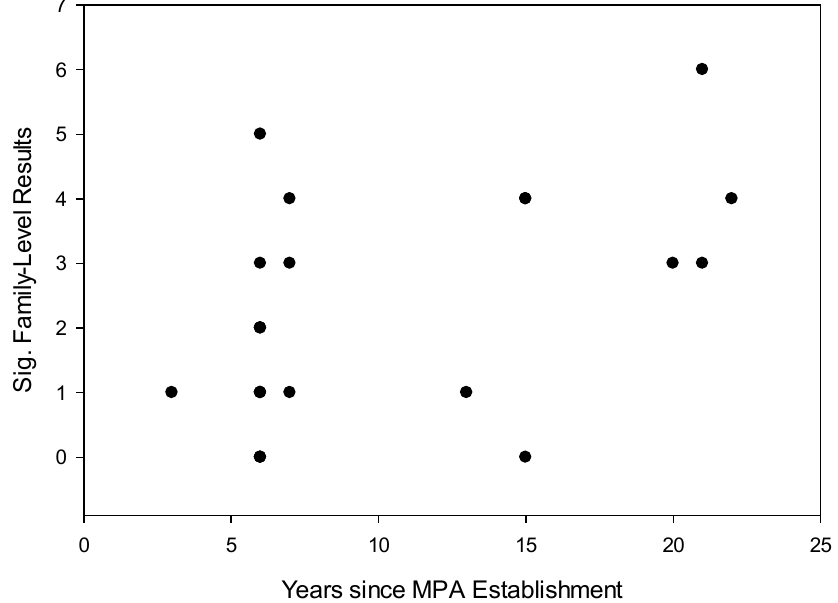
Figure 7. Correlation between the occurrence of statistically significant disparities in fish body size distribution between MPAs and fished reefs across MPAs of varying age, based on the results of family-level K-S tests. A Spearman rank correlation indicated a significant, positive association between the two variables (rs = 0.500; p =